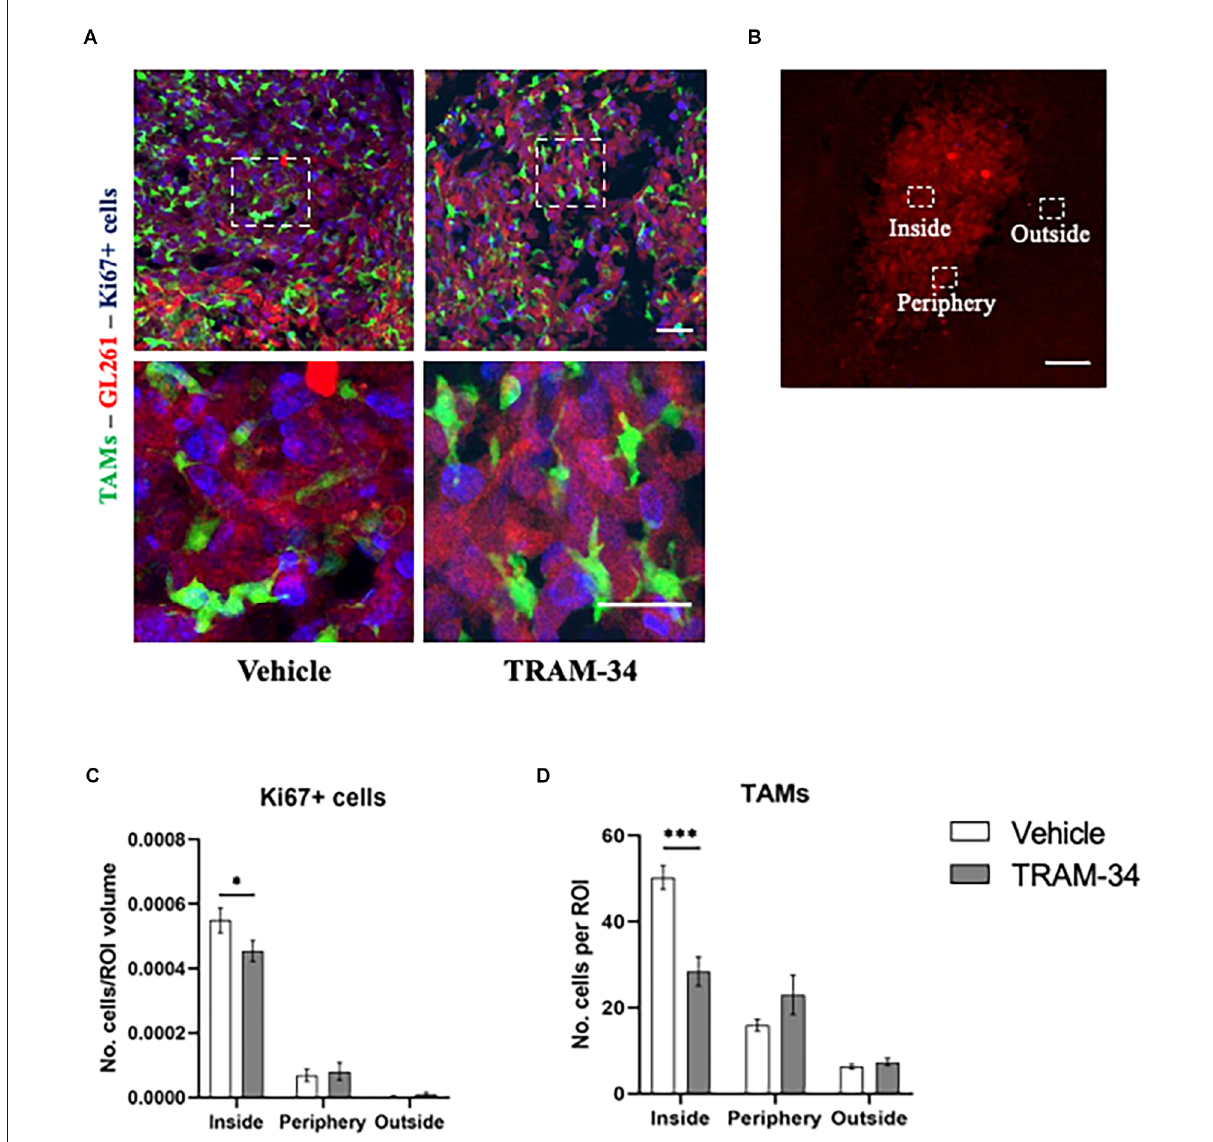
FIGURE2 Immunofluorescence analysis of proliferation marker Ki67. (A) Representative confocal images at 40 × magnification of inside the tumor of CX3CR1 mice, stained with anti-Ki67 antibody (blu) with a higher magnification below, at T2. Scale bar = 30 µ m. (B) Representative 2D image of the tumor cells in a brain slice of 40 µ m. The boxes indicate the three considered areas. The image was acquired with a fluorescence microscope, 5 × objective. Scale bar = 100 µ m. (C) The number of Ki67 positive cells per region of interest (ROI) and (D) number of TAMs per ROI inside, peripherical, and outside the tumor of vehicles and TRAM-34 groups ( n = 3/group). Analysis with two-way ANOVA, mean ± SEM ∗ p < 0.05; ∗∗∗ p <